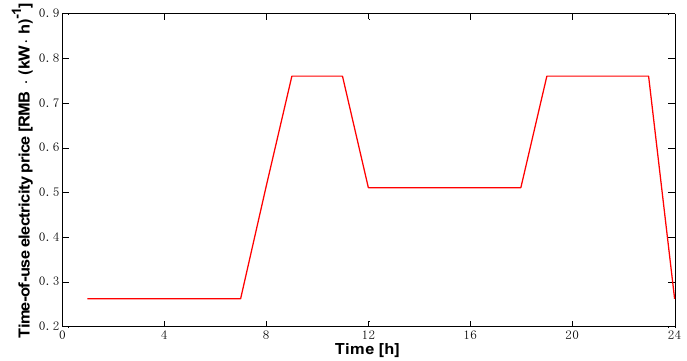
Figure 5. Time-of-use electrical price curve of the power grid.